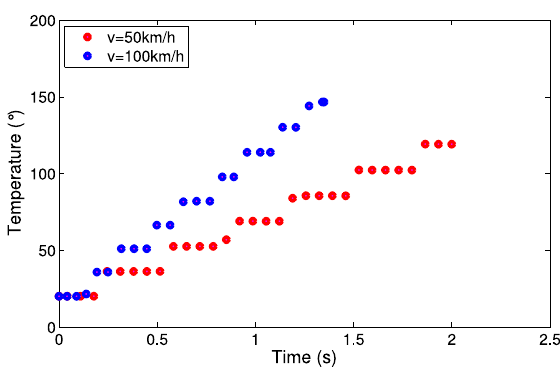
Figure 20. Temperature increase at a tire tread node at velocities of v = 50 km/h and 100 km/h and β